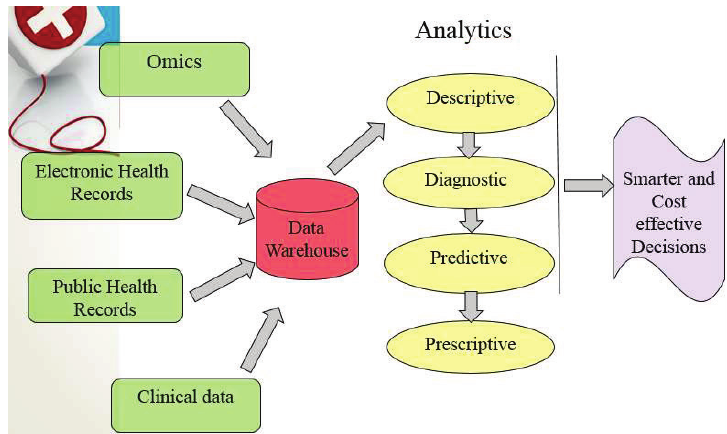
Fig. 4. Data Flow collected from e-health